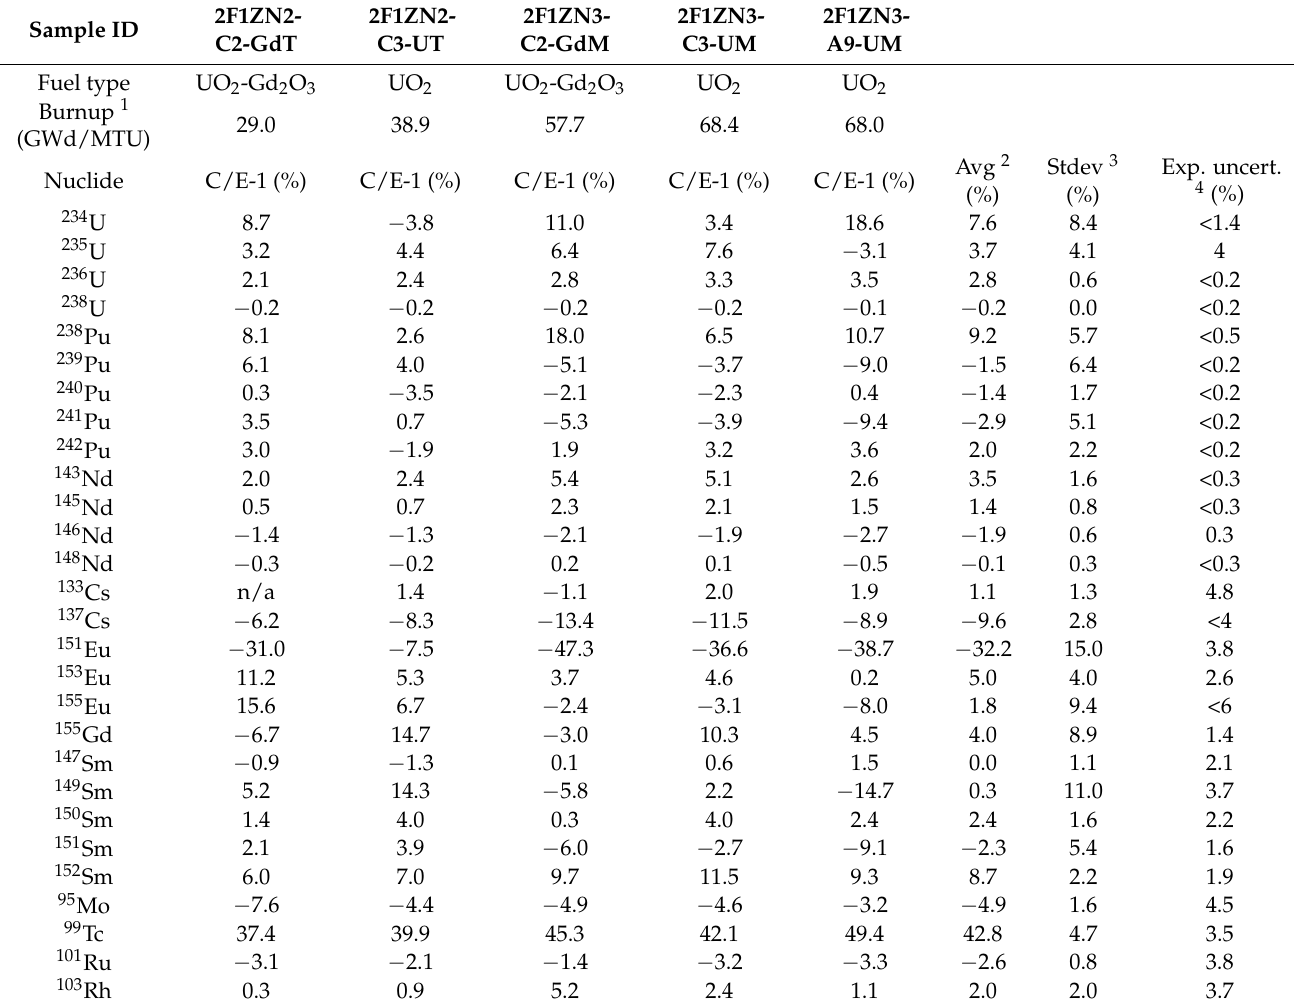
Table 3. Comparison between calculation and experiment for nuclide